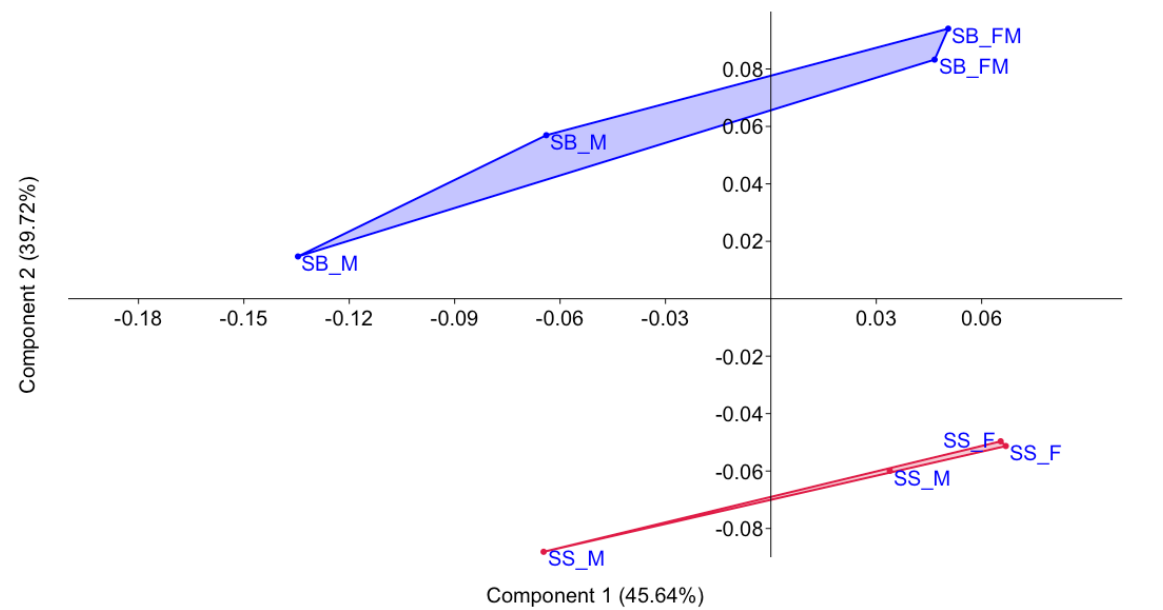
Figure 3. Principal component analysis of morphological characters for two species of Scutiger from Sikkim. Percent variation explained by each axis is provided in parenthesis. (SS_M - Scutiger sikimmensis Male; SS_F - Scutiger sikimmensis Female; SB_M - Scutiger boulengri Male; SB_F - Scutiger boulengri